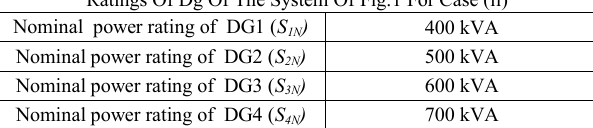
TABLE VI Ratings Of Dg Of The System Of Fig.1 For Case